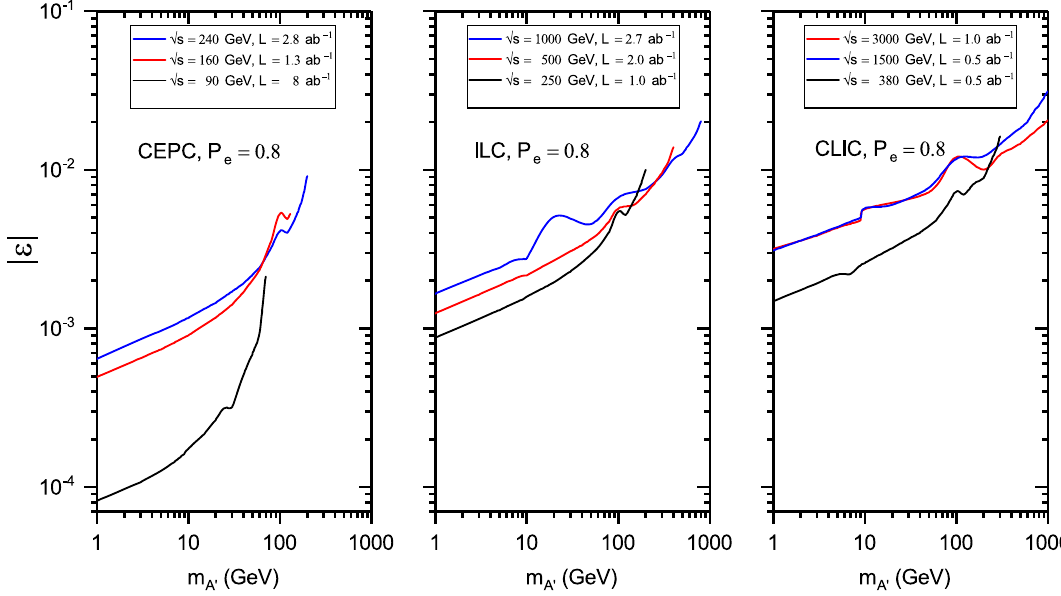
Fig. 10 The excluded bounds at the 95% CL on the dark photon mass m A (cid:2) and kinetic mixing parameter ε for the invisible dark photon production in the collision of the unpolarized real photon with the electron whose polarization is equal to